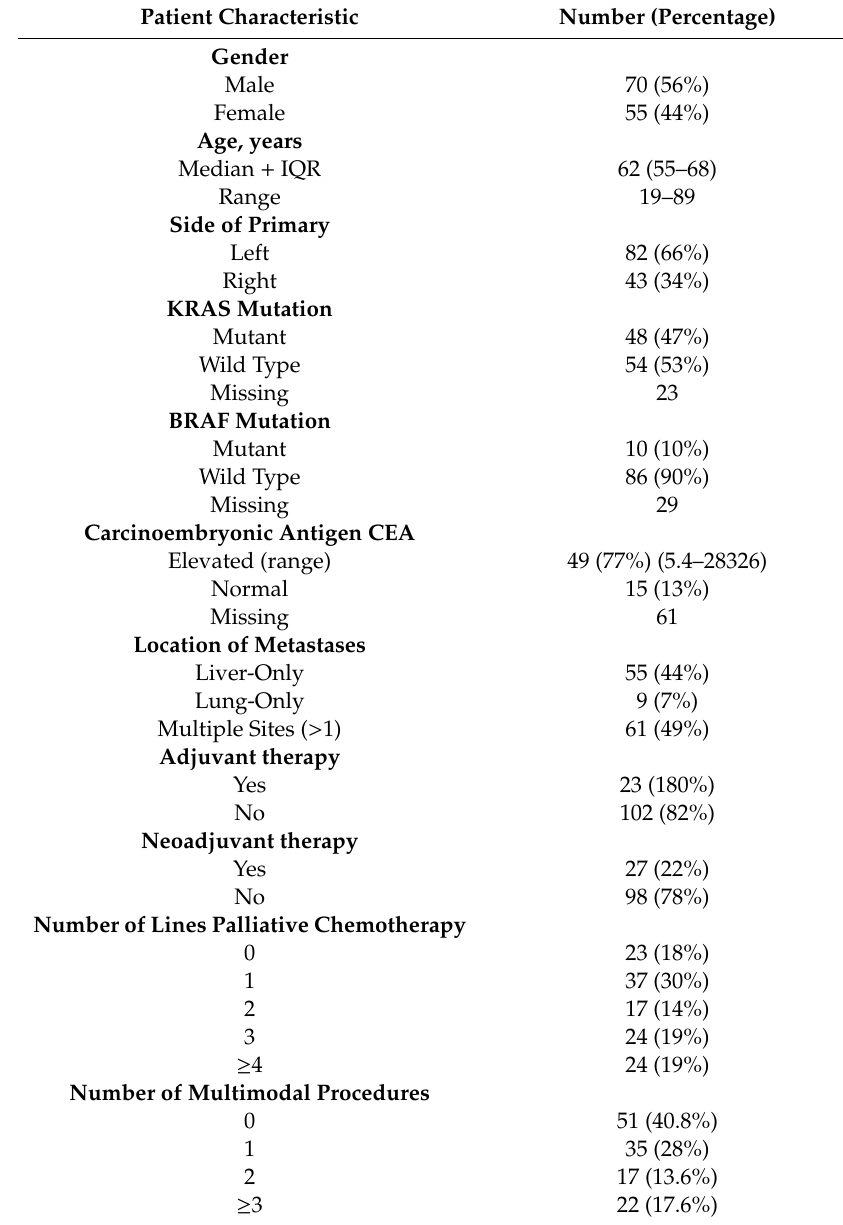
Table 1. Patient